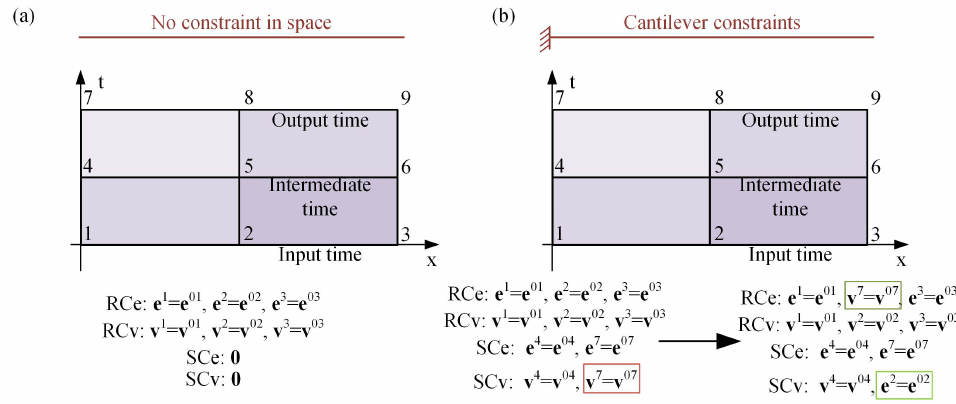
Figure 2. ( a ) RC and SC constraints in no-constraint cable. ( b ) RC and SC constraints in cantilever cable and the constraint conversion